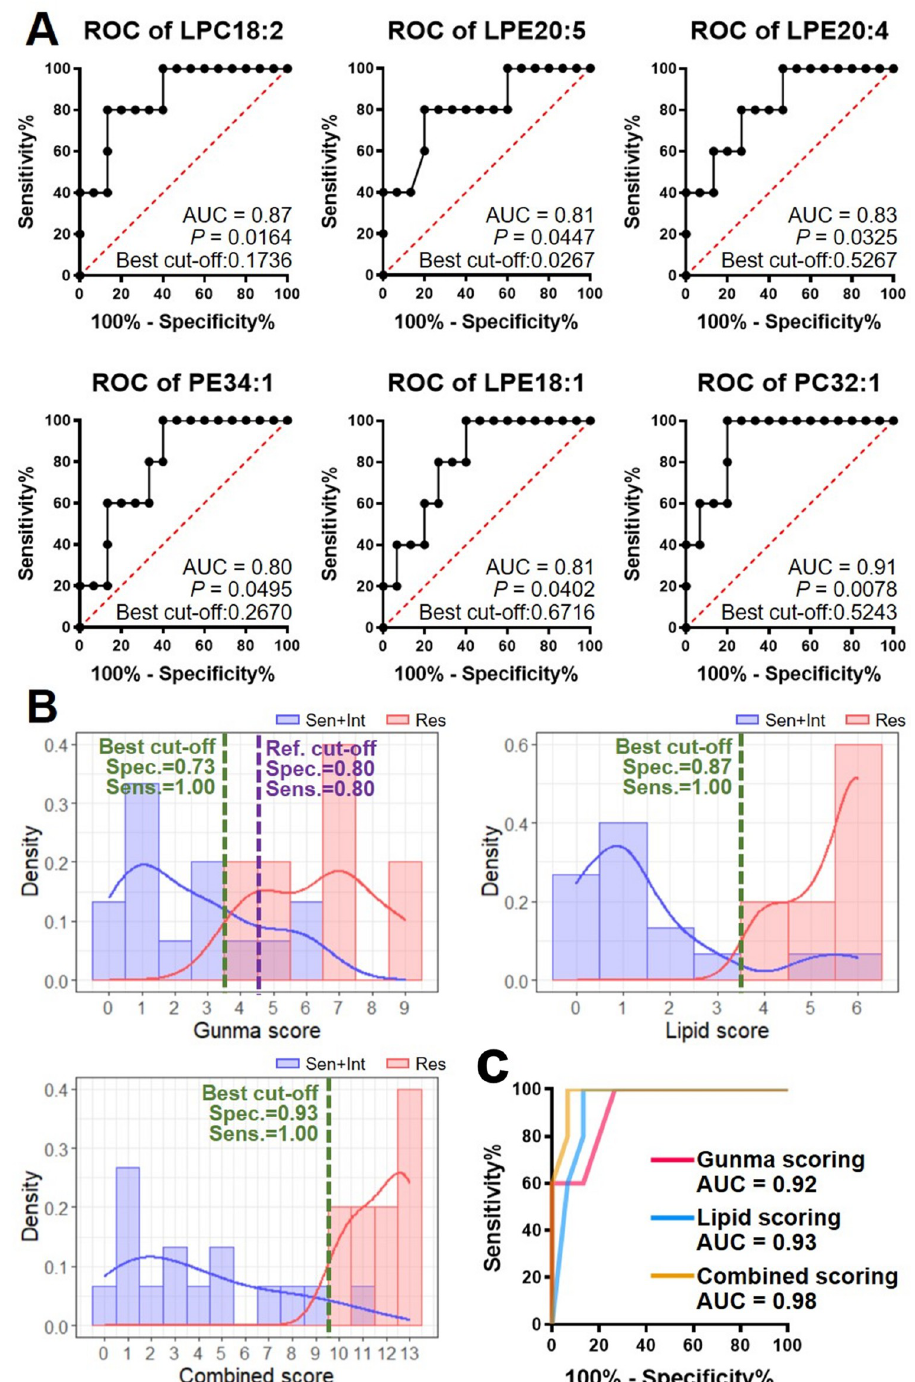
Fig 3. (A) ROC curves of these lipid species for diagnosing IVIG resistance, with AUC, P -value of the curve, and the best cut-off. (B) The histograms of IVIG-sensitive + intermediate (blue) and IVIG-resistant (red) patients based on Gunma scoring, lipid scoring, and combined scoring, respectively. The purple dashed line indicates the referred cut-off of Gunma score, and the green dashed lines indicate the best cut-off calculated for the current samples. (C) ROC curves of Gunma scoring, lipid scoring, and combined scoring for IVIG resistance